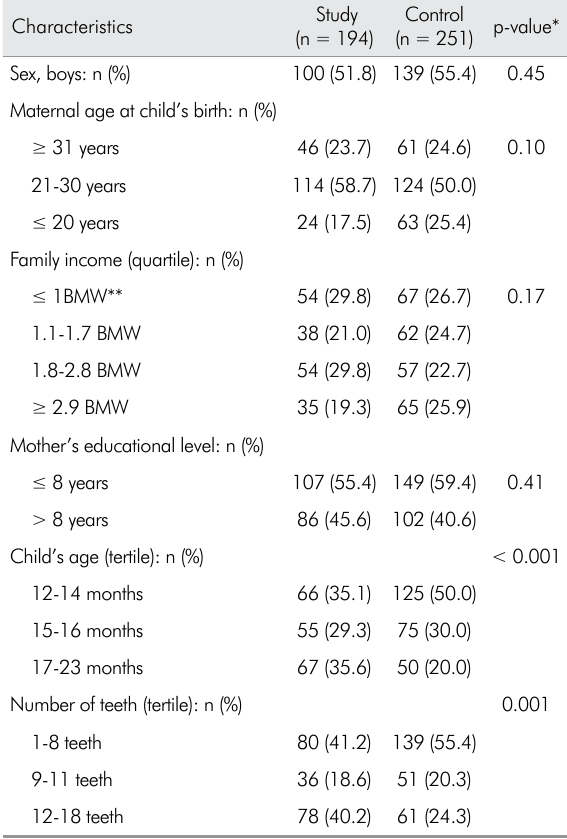
Table 1. Distribution of the participants’ characteristics in the study and the control groups. Pelotas, Brazil, 2011 (n = 445).